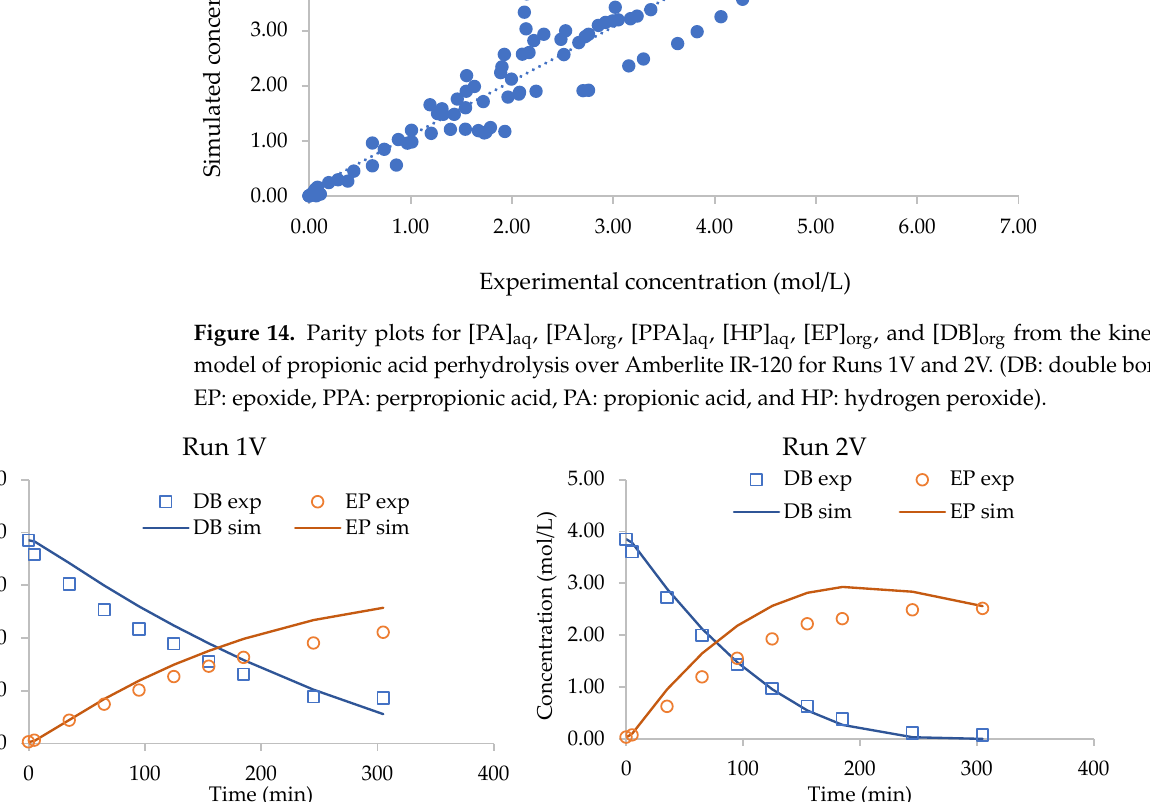
Figure 15. The fit of the model to Runs 1V and 2V for the validation stage. (DB: double bond and EP: epoxide).